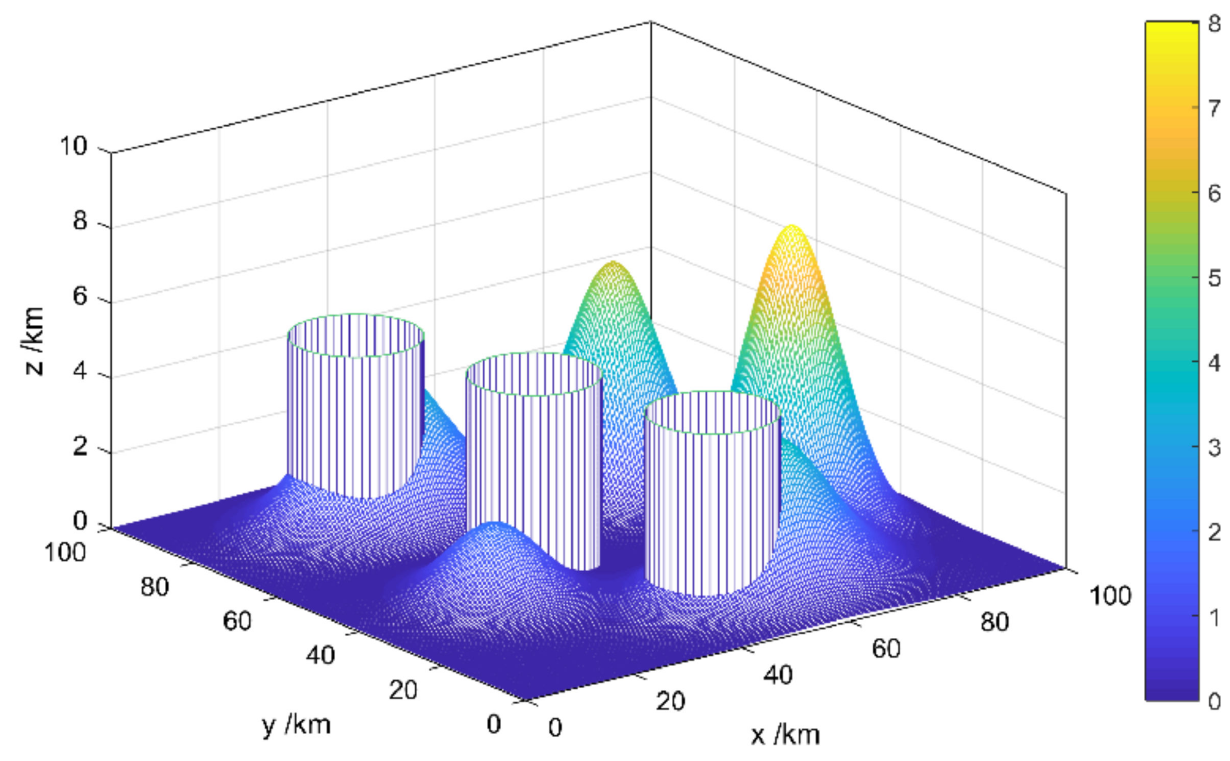
Figure 9. UAV path planning workspace in complex